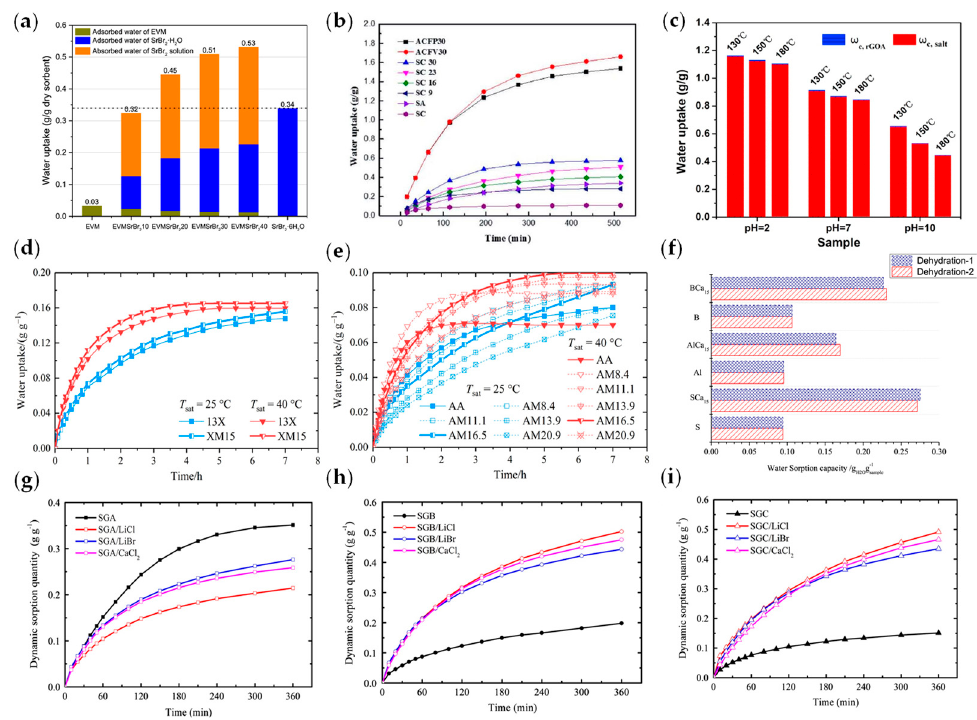
Figure 20. E ff ect of host matrix on adsorption performance of the composites: ( a ) expanded vermic- Figure 20. Effect of host matrix on adsorption performance of the composites: ( a )